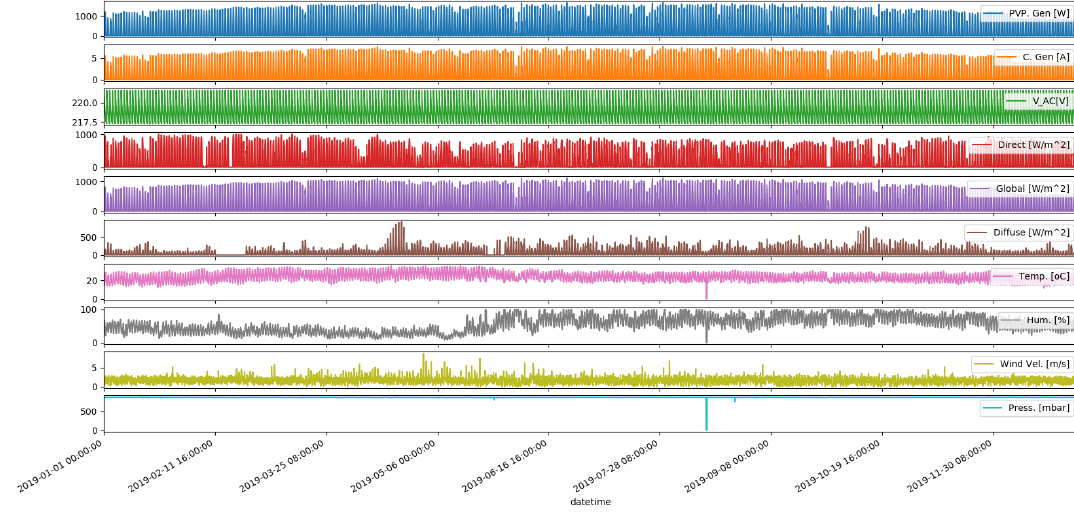
Figure 4. ESOLMET Dataset, IER, Temixco, 2019 [29].